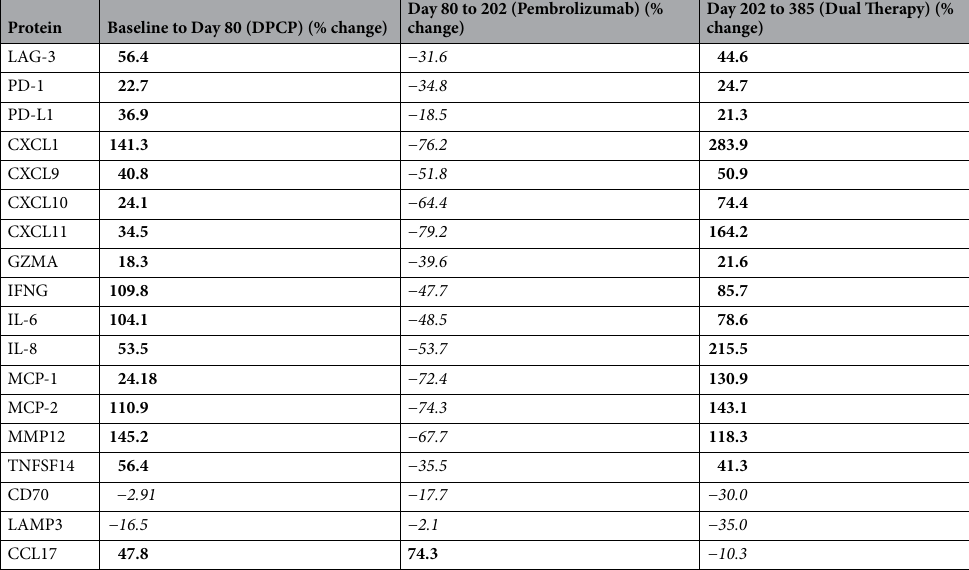
Table 1. Proteomic profiling of tissue samples highlighting responses to DPCP monotherapy (baseline to Day 80), pembrolizumab monotherapy (Day 80 to Day 202), and DPCP and pembrolizumab dual therapy (Day 202 to Day 385). Results are depicted as percent change between each time point. Bold text indicates increases in protein level, while italic text indicates decreases in protein level.